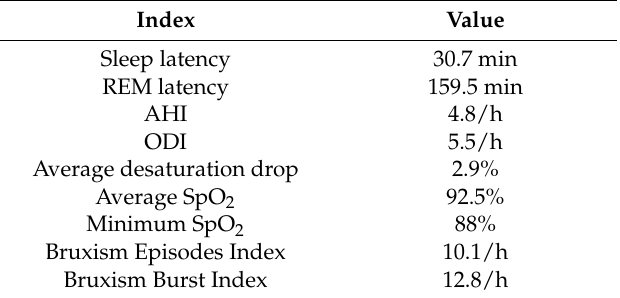
Table 2. Polysomnography